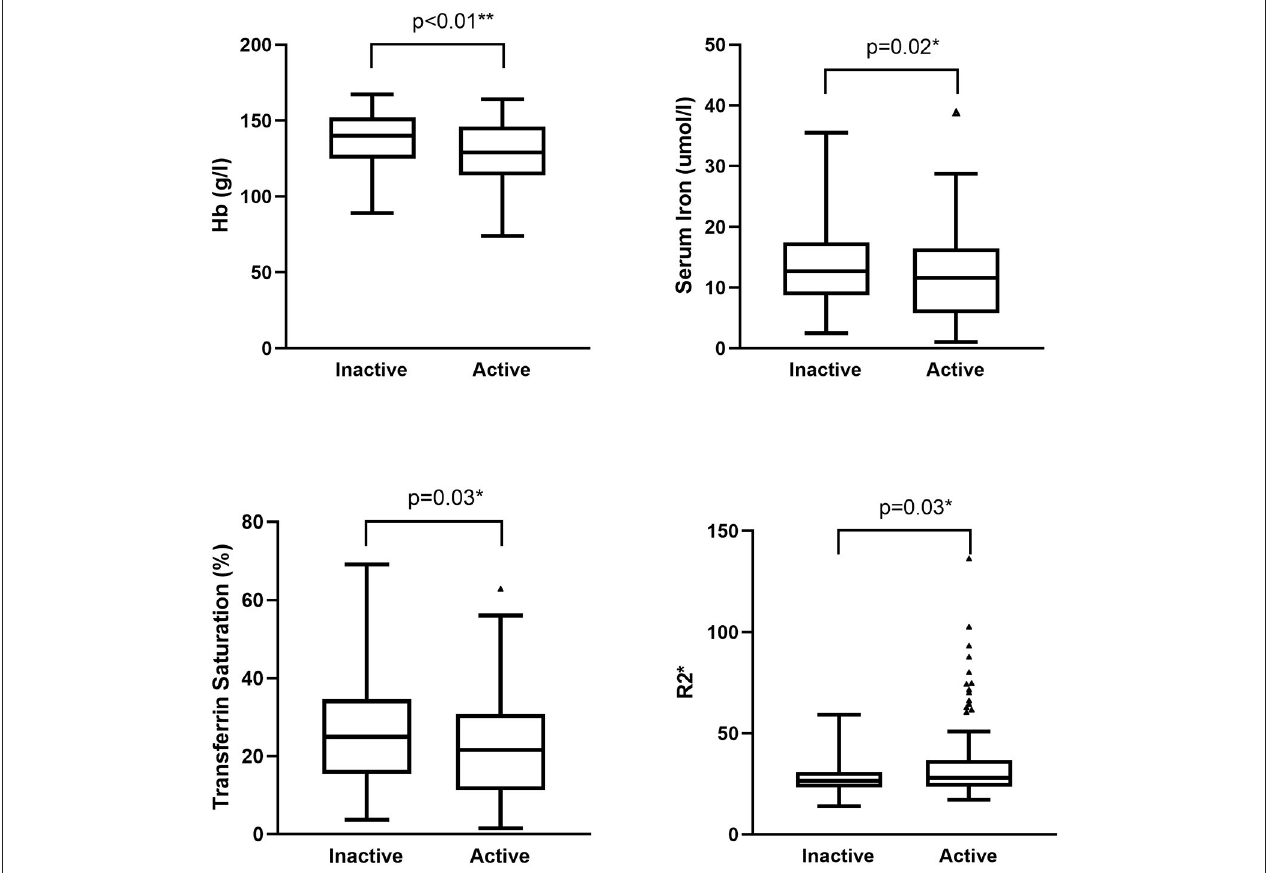
FIGURE 3 | Difference in iron status indices and R2* between patients with active and inactive disease. Hemoglobin, serum iron, and transferrin saturation were higher in patients with inactive CD ( P < 0.01, 0.02, and 0.03, respectively). R2* was higher in patients with active CD ( P = 0.03). CD, Crohn’s disease.